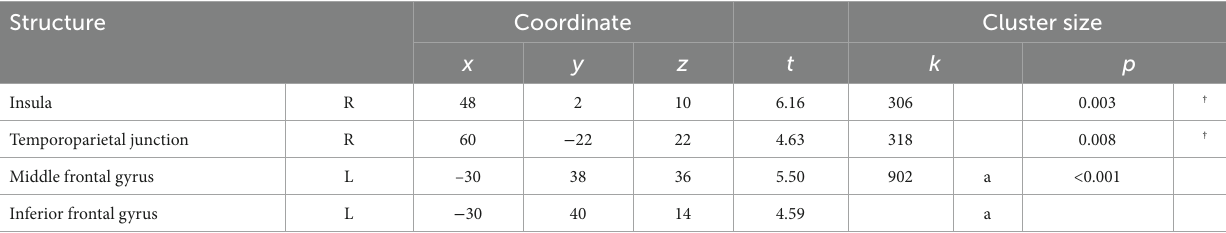
TABLE 2 Differential activation during context presentation (EmpCon >